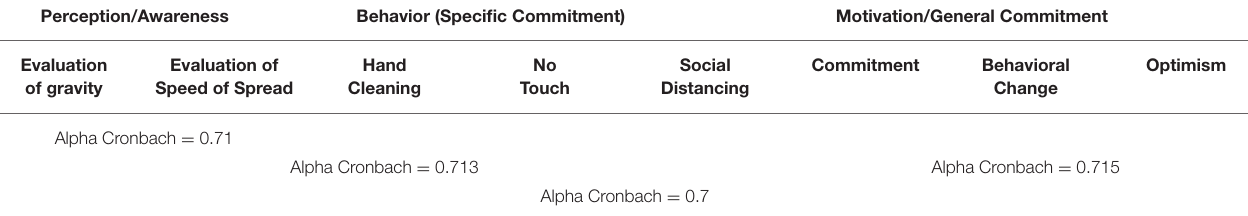
TABLE 1 | Reliability of the different components of the AB-SURVEY.